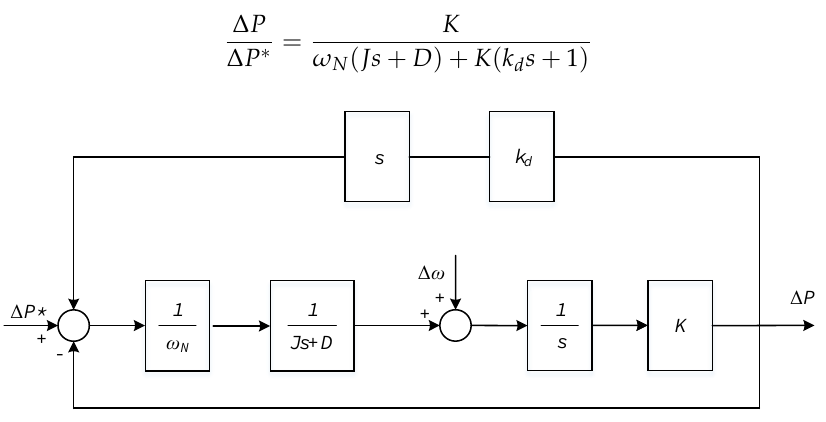
Figure 7. Small signal model of active power of proposed VSG controller.